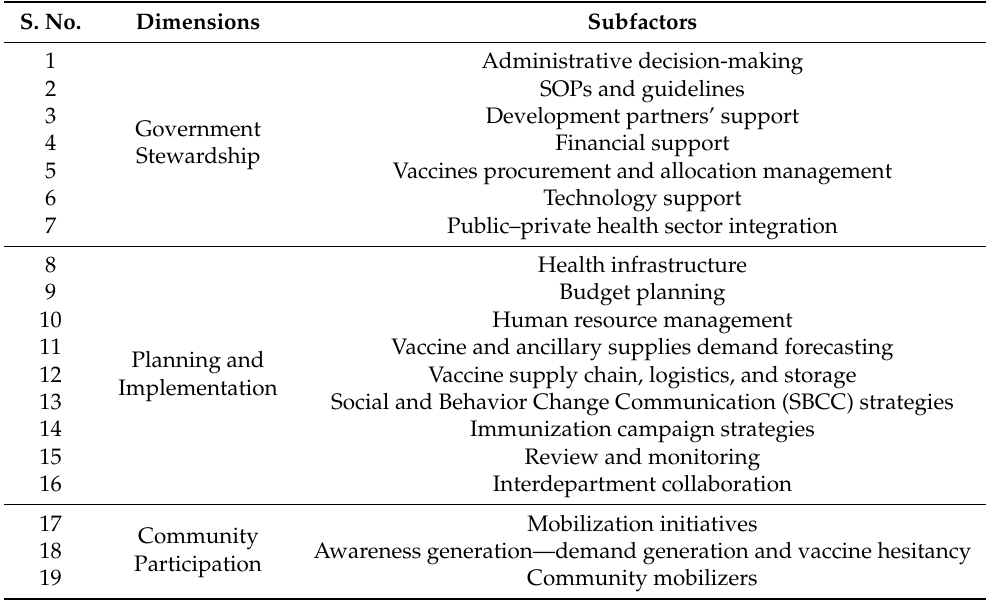
Table 1. Dimensions of the framework for immunization